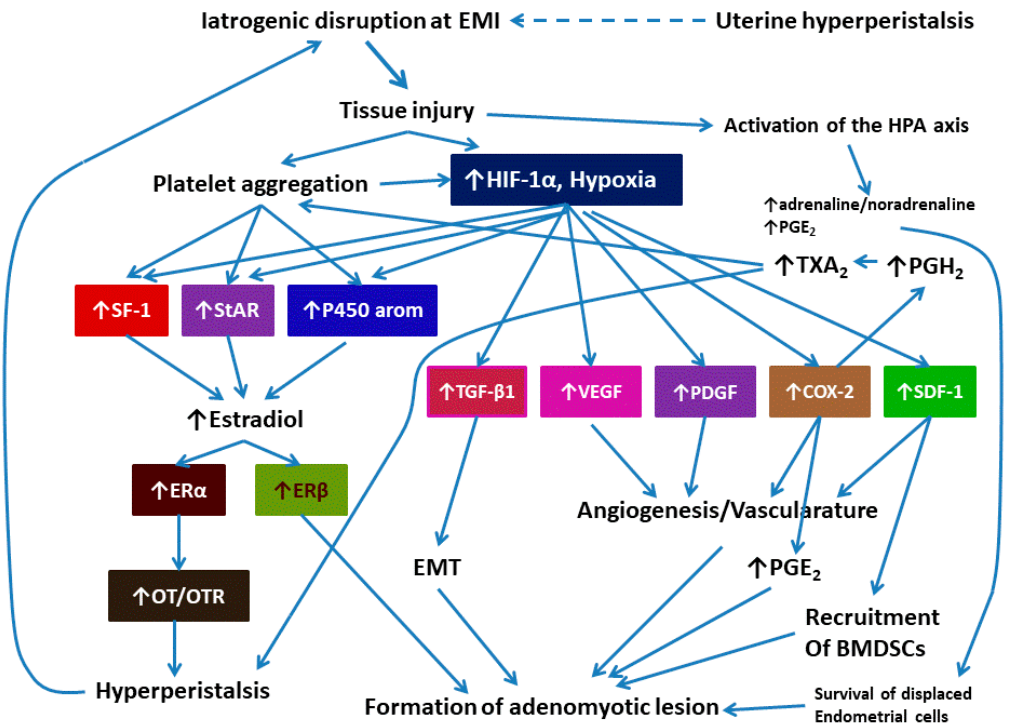
Figure 3. Schematic illustration of the formation of adenomyotic lesions due to the endometrial–myometrial interface disruption (EMID). Iatrogenic procedures causes disruption at the endometrial–myometrial interface (EMI), which leads to platelet aggregation and the induction of HIF-1 α , e ff ectively causing tissue hypoxia. Uterine hyperperistalsis may also induce EMI disruption (shown in dashed arrow). As a result, genes involved in estrogen production are upregulated, resulting in increased local production of estrogen and subsequent induction of both ER α and ER β , which, in turn, leads to the induction of the OT / OTR signaling and increased uterine peristalsis. In addition, tissue hypoxia activates TGF- β 1, VEGF, PDGF, COX-2, and SDF-1 signaling pathways, leading to increased angiogenesis, vascularature, and the recruitment of BMDSCs to the wounding site. The induction of COX-2 would also increase the production of PGH 2 and TXA 2 , which also enhances uterine peristalsis. Moreover, the TGF- β 1 signaling pathway induces EMT, leading to the invasion of endometrial epithelial cells to the EMI and further down to the myometrium. Tissue injury also would activate the HPA axis, leading to the release of catecholamines and PGE 2 , which collectively result in impaired cell-mediated immunity and, as such, enhances the survival of displaced and dispersed endometrial cells within the myometrium. All these events ultimately lead to the formation of adenomyotic lesions in